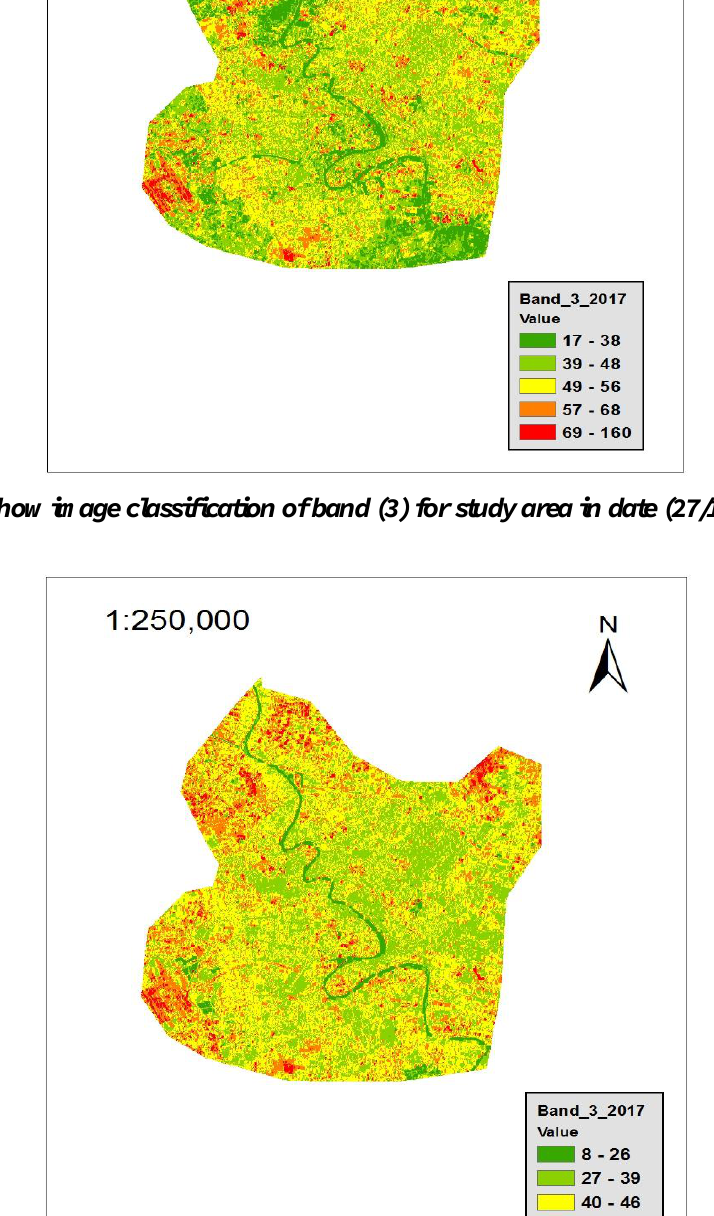
applying the Eq.(1) and The result show in